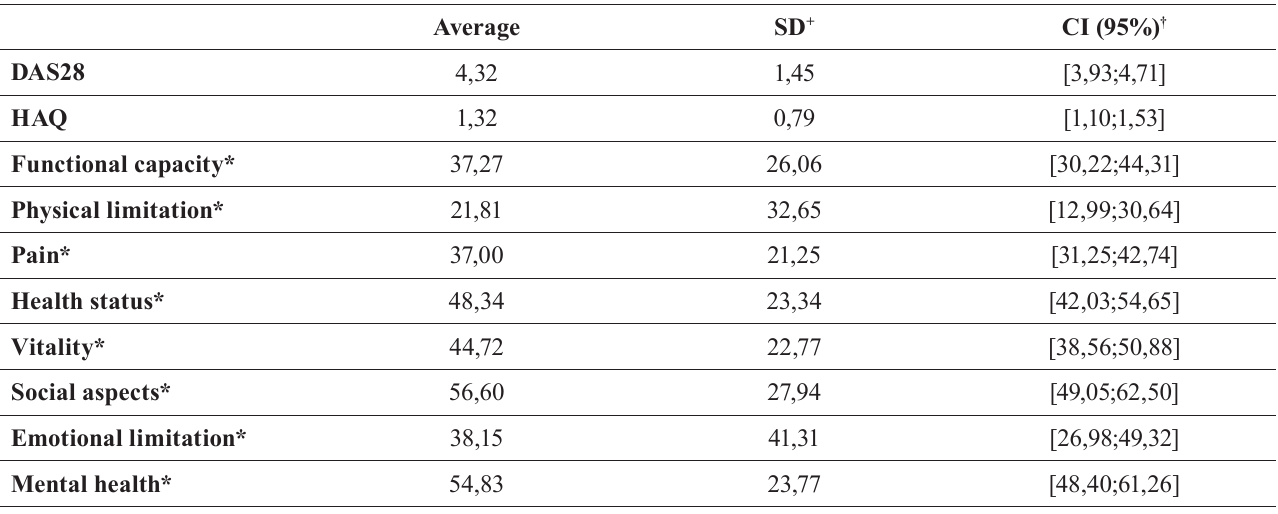
TABLE I - D escription of the scores obtained by the HAQ and SF-36 questionnaires Average SD + CI (95%) † DAS28 4,32